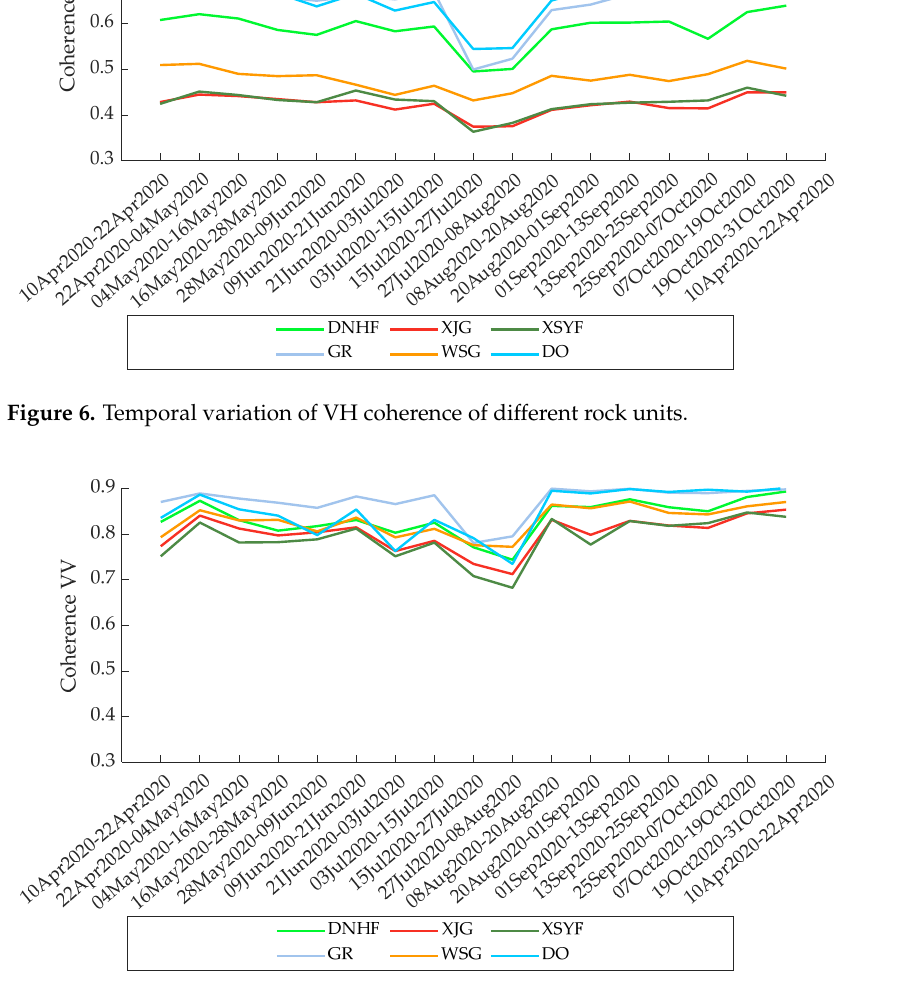
Figure 7. Temporal variation of VV coherence of different rock units.